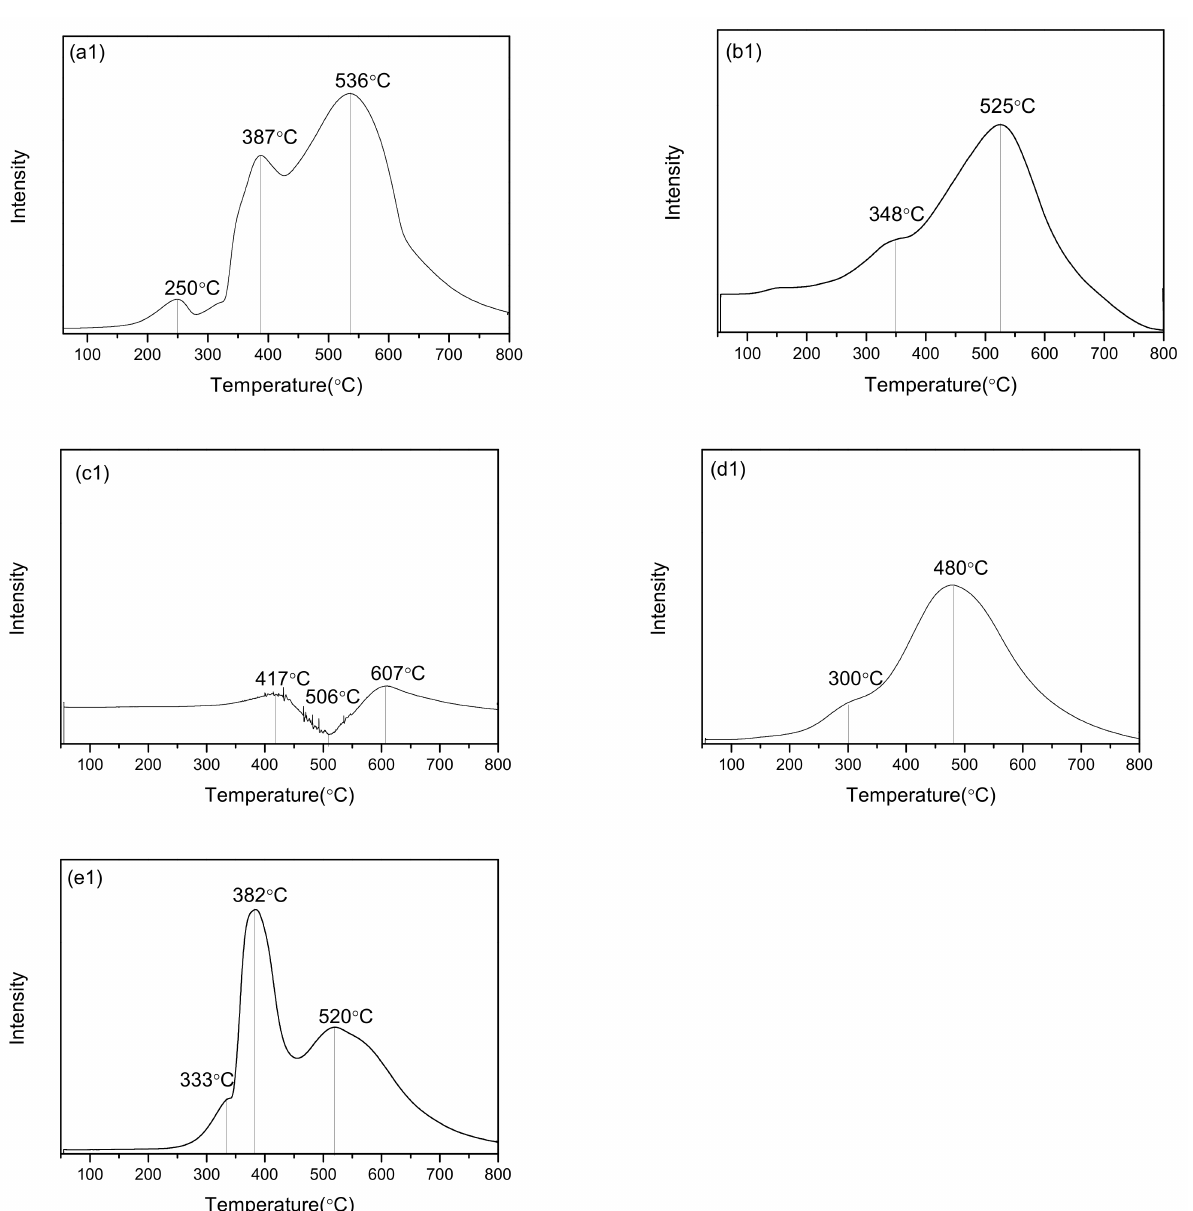
Figure 8. H 2 -TPR profiles of ( a1 ): Co/CNT, ( b1 ): Co/AC, ( c1 ): Co/GO, ( d1 ): Co/rGO, ( e1 ):